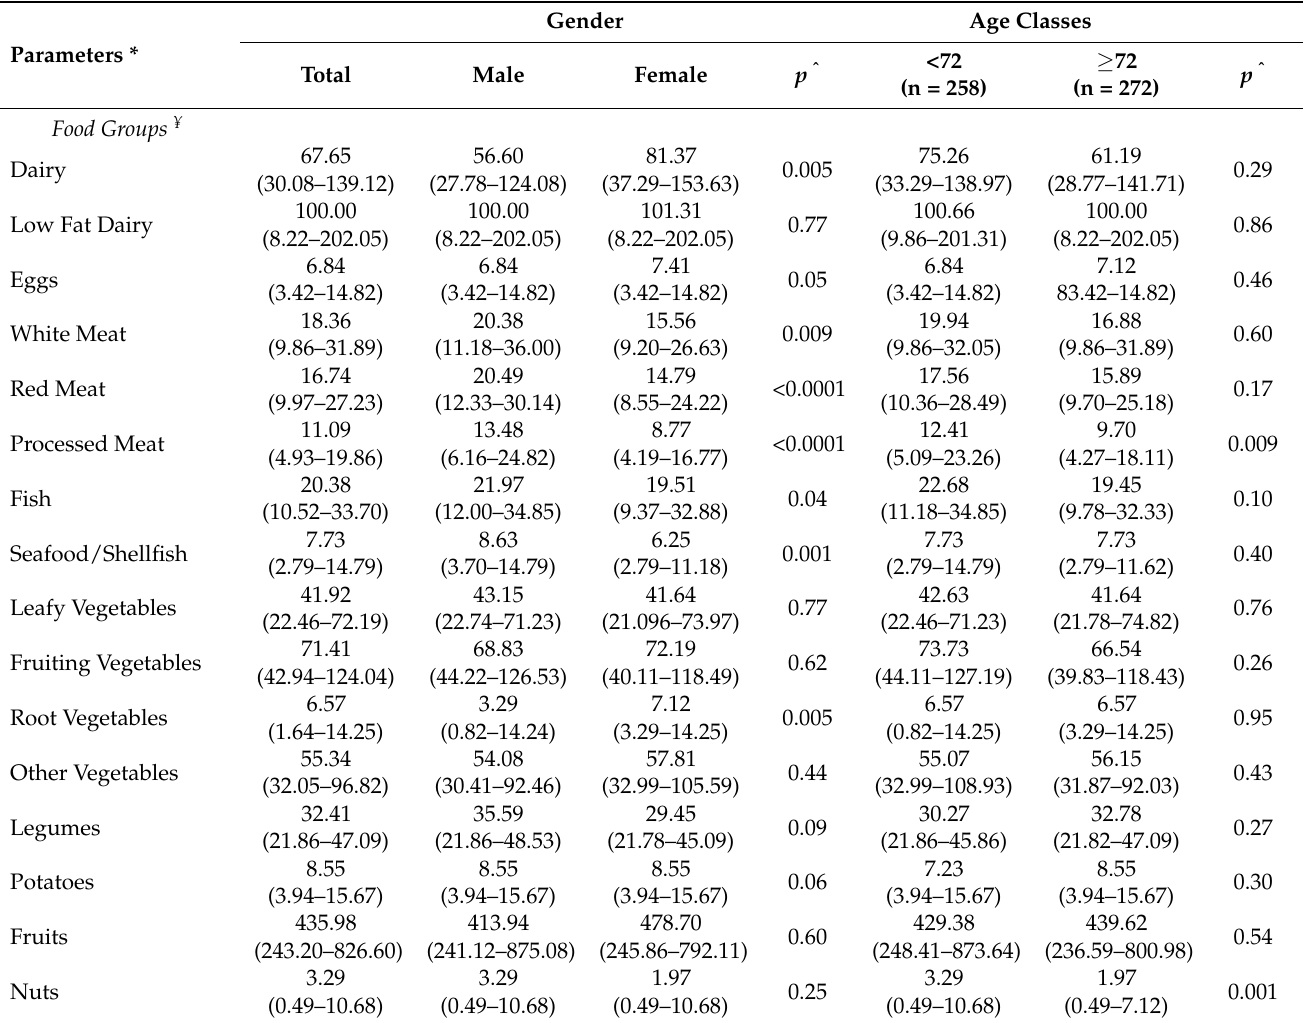
Table 2. Food groups average daily consumption (expressed in grams) by the sample ( n = 530). The Salus in Apulia